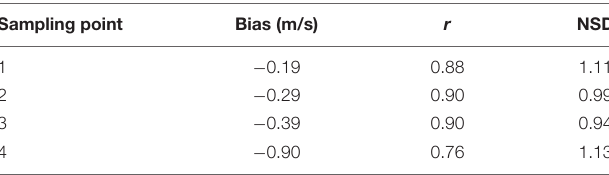
TABLE 1 | Wind speed statistical parameters, in four points shown in Figure 1B , for the 2007–2017 period: bias, Pearson correlation coefficient ( r ), normalized standard deviation (NSD).